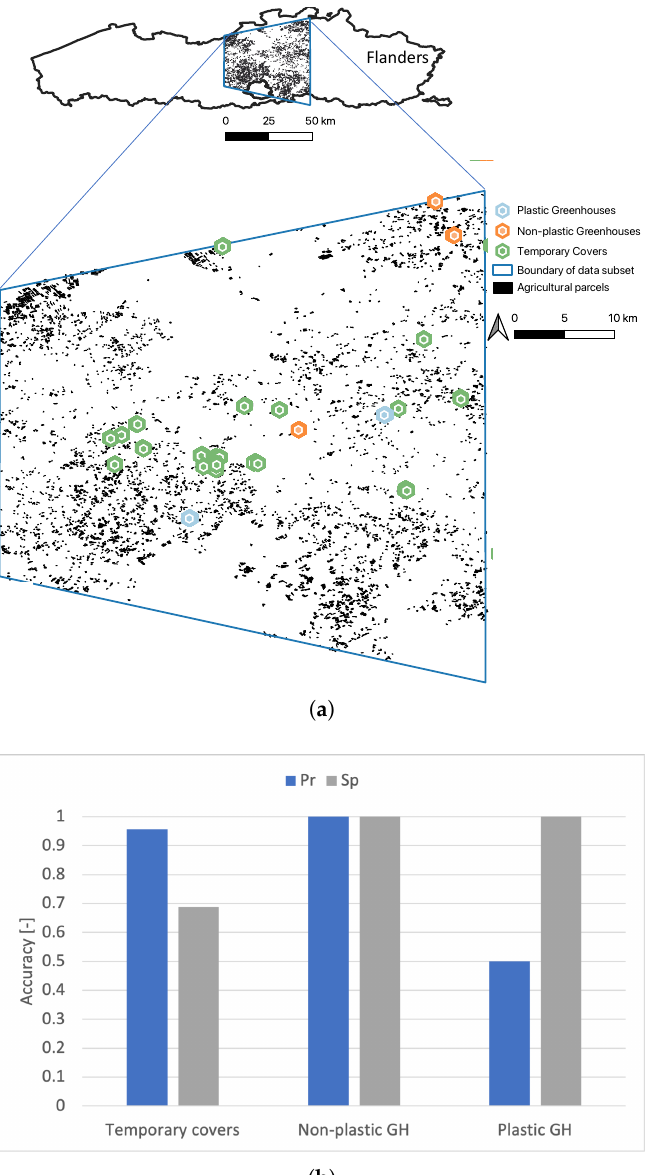
Figure 16. Identified covered parcels using Sentinel-2 data acquired on 20 April 2020. The covered area is a subset of the dataset located in central Flanders where high resolution imagery were available for 11 April 2020. ( a ) Detected artificial covers of parcels with potential bare soil satisfying NDVI < 0.3. ( b ) Precision ( P r ) and sensitivity ( S p ) accuracy